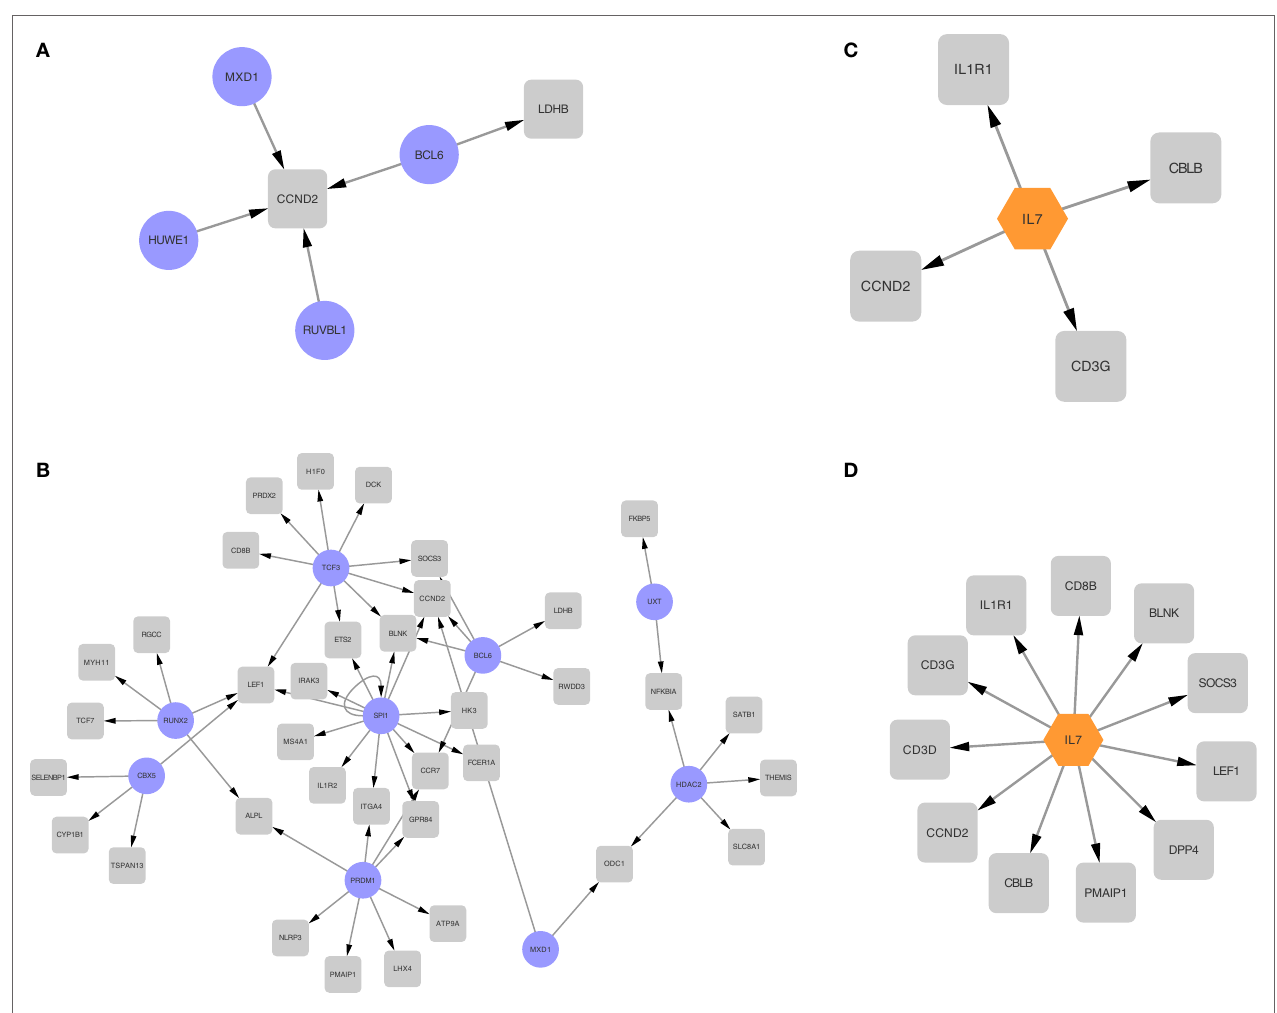
FiGURe 7 | Regulatory networks for second and third trimester differentially expressed genes. Transcription regulation networks for differentially expressed genes in the second trimester (a) and third trimester (B) , where the transcription factors are represented with a purple round node and the differentially expressed targets are represented with a gray square node. Cytokine networks for second trimester (c) and third trimester (D) , where the transcription factors are represented with an orange hexagon node and the differentially expressed targets are represented with a gray square